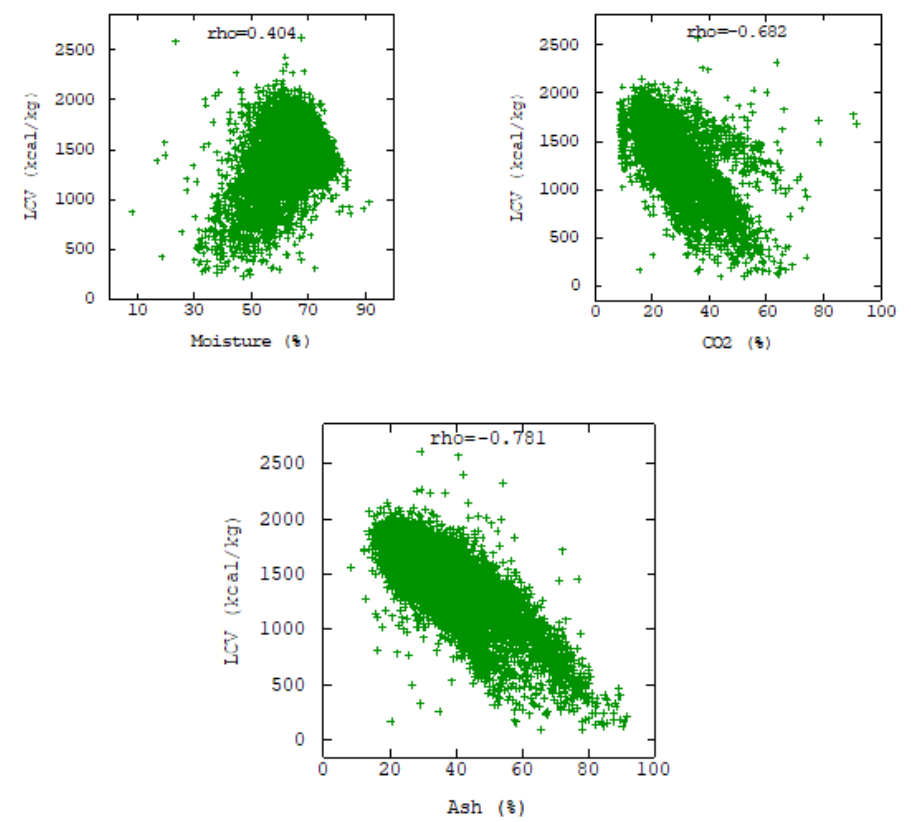
Figure 7. Scatter plots of LCV versus CO 2 , moisture, and ash.